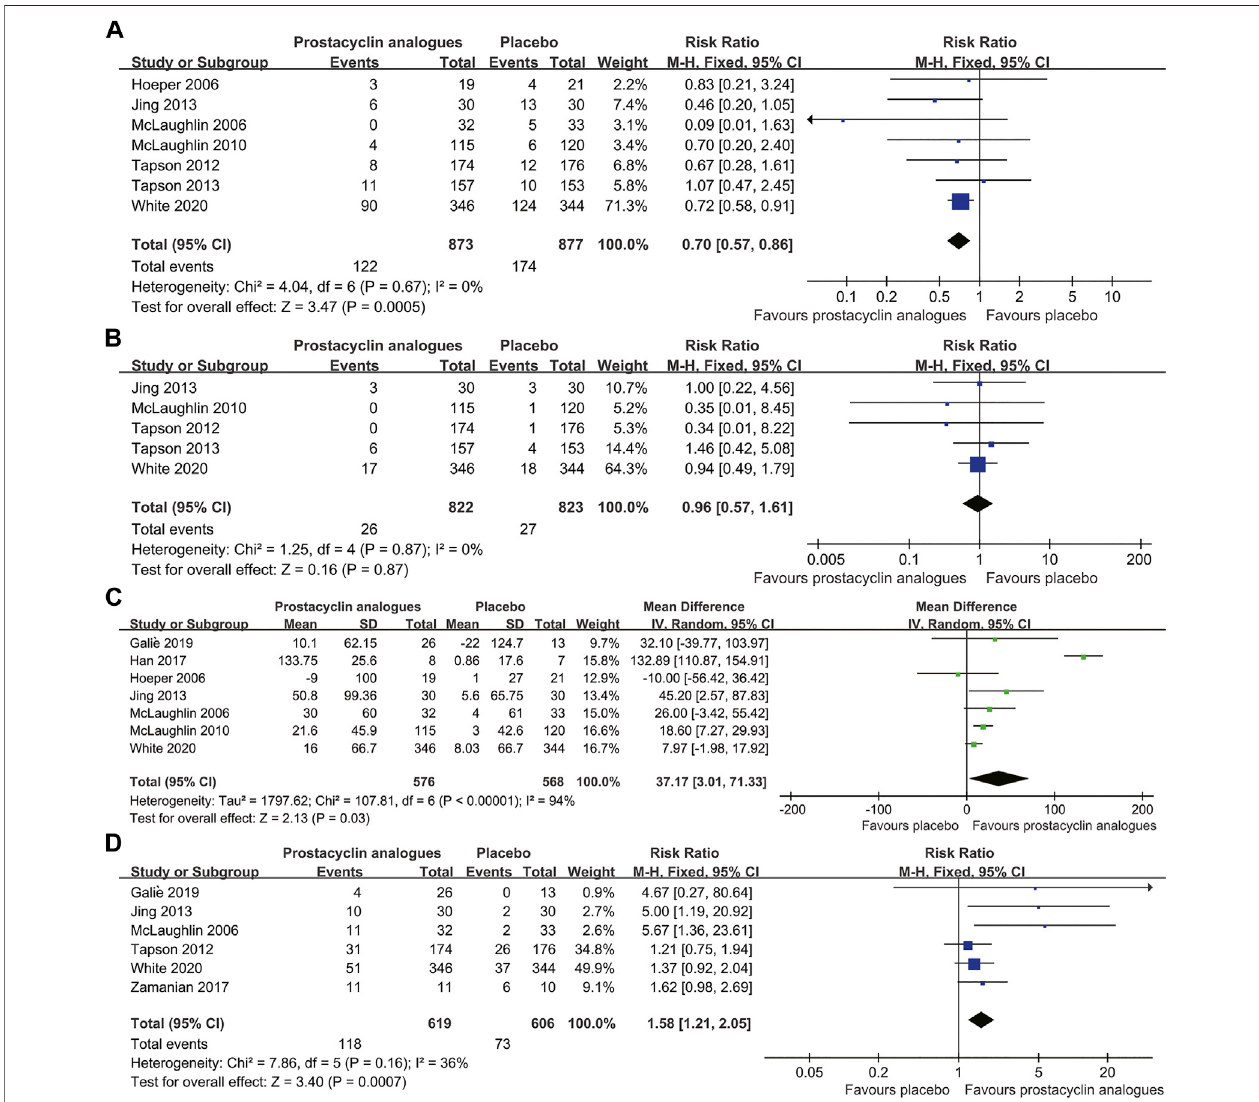
FIGURE 2 | Forest plot comparing prostacyclin analog group with control group for clinical worsening (A) , all-cause mortality (B) , 6-min walk distance (C) , and NYHA/WHO functional class (D) .